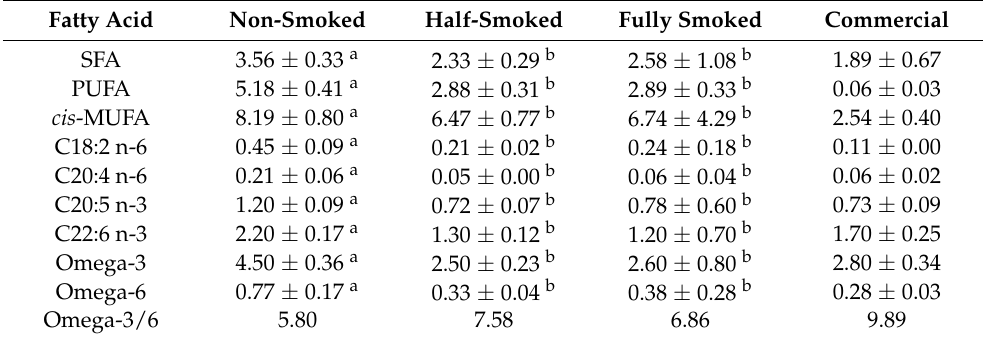
Table 2. Summary of nutritionally important fatty acid contents of FN non-smoked, half-smoked, fully smoked and commercial salmon 1 .